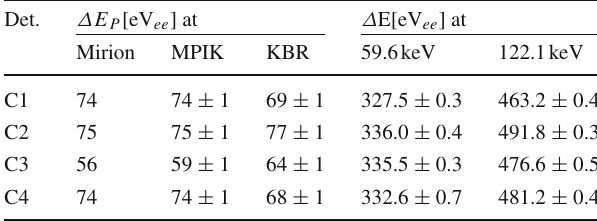
Table 8 Peak resolutions of the four Conus detectors in terms of FWHM. The first three columns are pulser measurements at Mirion– Lingolsheim, MPIK and KBR. The last two columns correspond to 241 Am and 57 Co source calibrations at MPIK